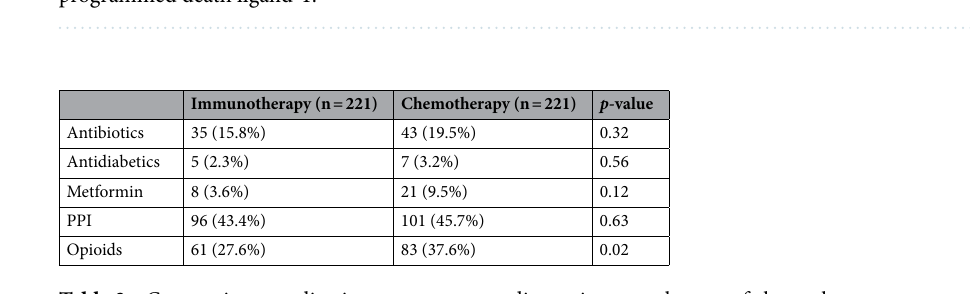
Table 2. Concomitant medication exposure according to immunotherapy of chemotherapy treatment. Abbreviations: PPI, proton pump